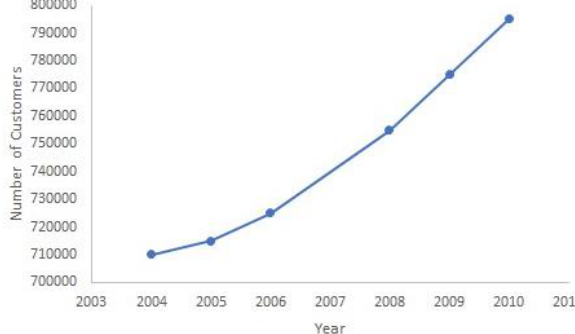
Fig. 2. Increase in water customers in Jakarta from 2004-2020